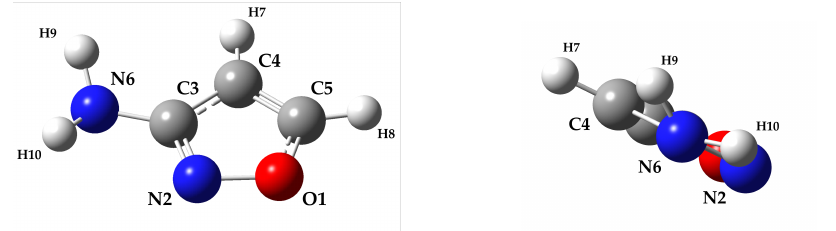
Figure 1. Molecular structure and atom labeling of 3-aminoisoxazole. On the right, a side view of the molecule shows the hydrogen position with respect to the ring plane.